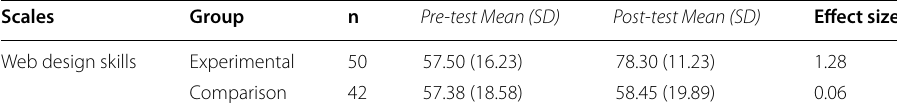
Table 3 The pre‑test and post‑test of students’ web design skills Scales